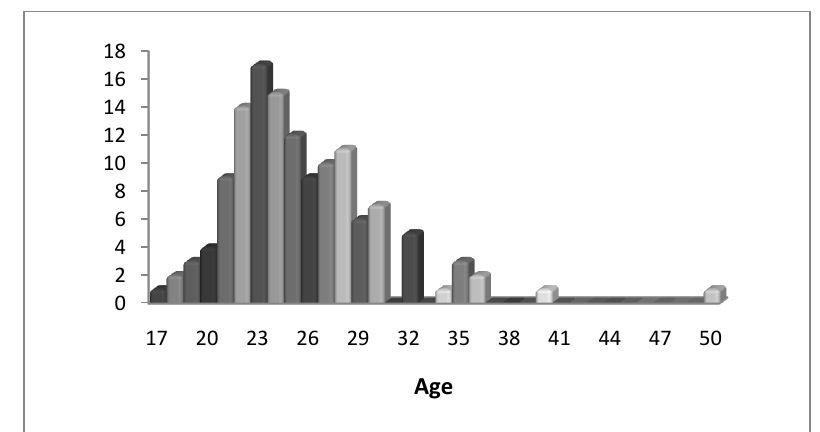
FIGURE 1: Age distribution of respondents, 2008 Source: Survey data